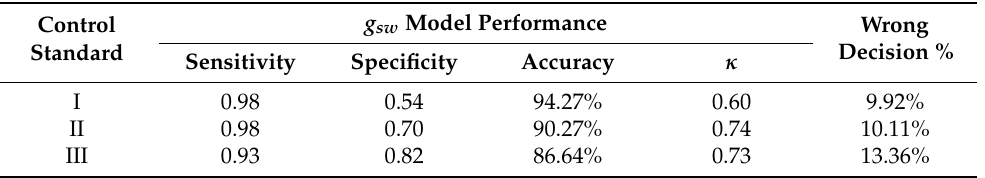
Table 5. Performance of g sw status models and the percentage of wrong decisions of the strategy under the three control